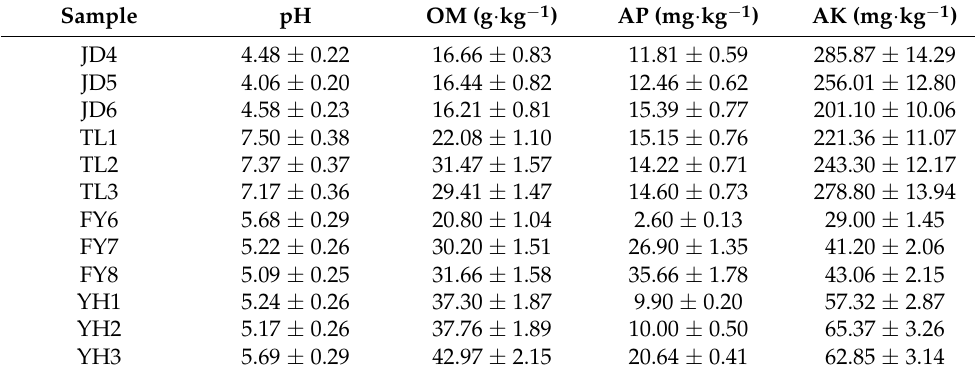
Table 4. Chemical properties of soil samples from Fuyang and Yuhang districts, and from Jiande and Tonglu